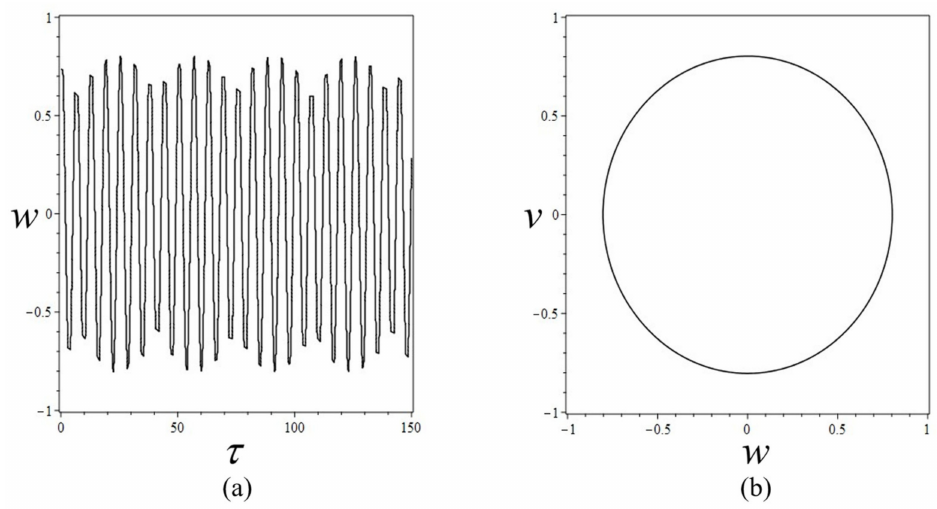
Figure 6. Dynamic response diagram of primary resonance: ( a ) diagram of transverse displacement versus time, ( b ) Phase